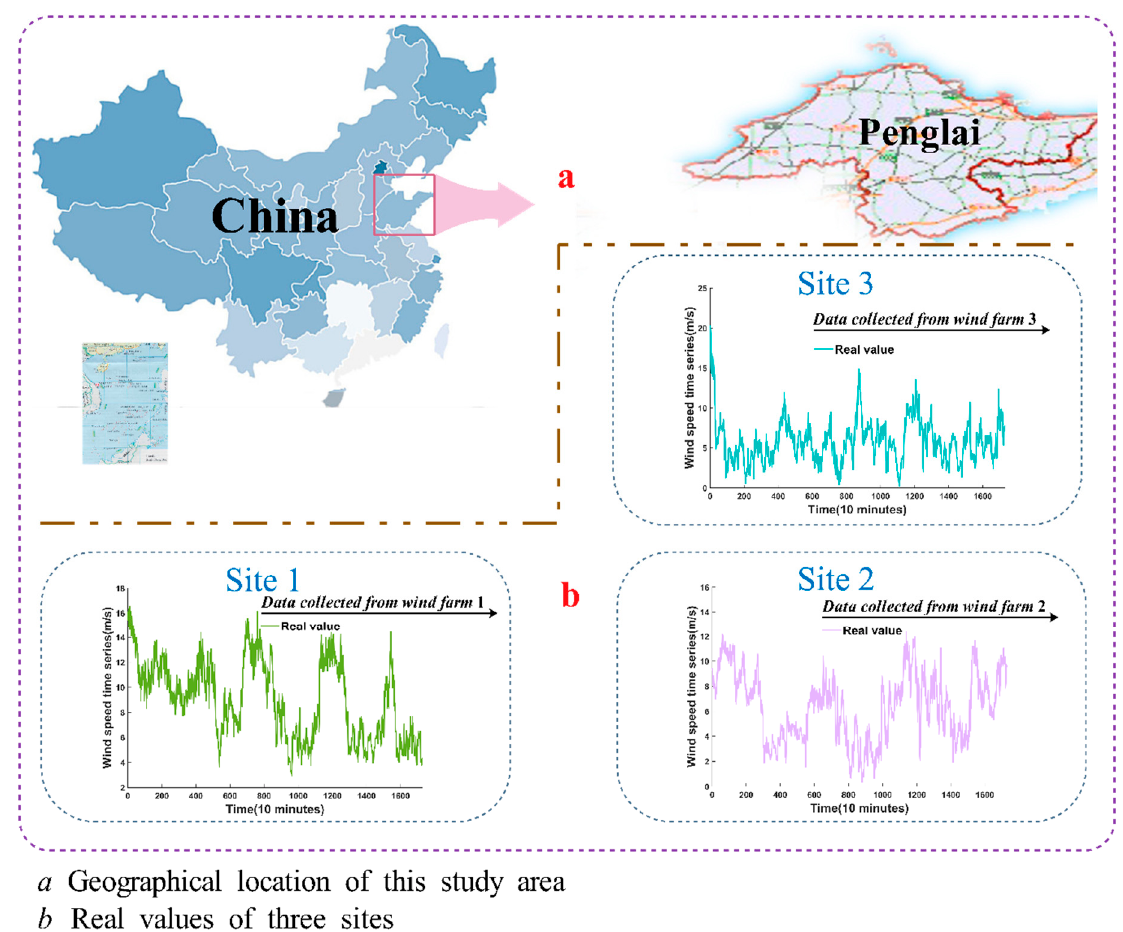
Figure 3. Geographical position of the survey regions and actual values of three stations.